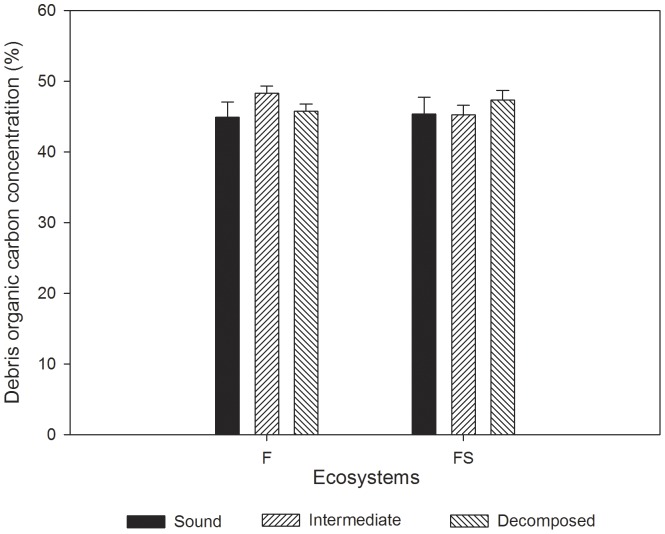
CWD organic carbon concentrations of two ecosystems in the karst area, southwestern China.F and FS are the abbreviations of secondary forest and forest - shrub transition, respectively. Error bars represent the standard errors.